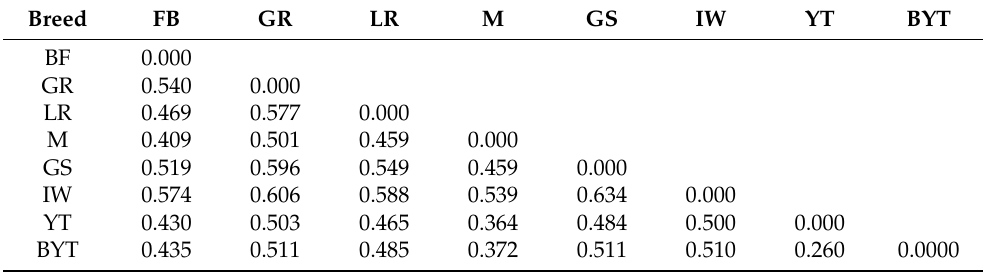
Table 1. Reynolds genetic distance ( θ w ) values of eight study dog